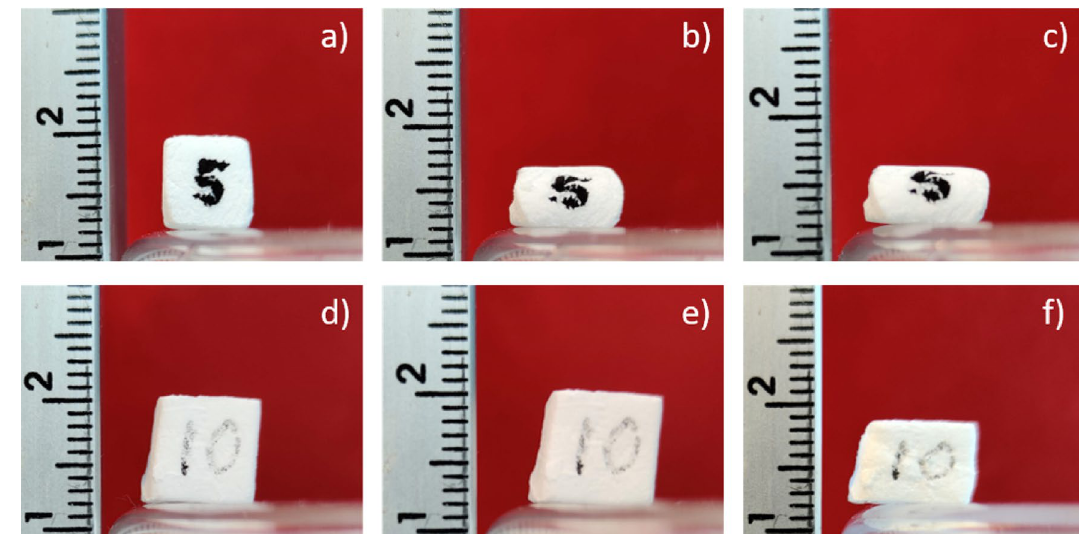
Figure 8. Cube-shaped foam samples made with either 5 or 10% polypropylene were exposed to increasing weights and photographs before and after the application. For the 5% sample the initial sample is depicted in ( a ). In ( b ), the sample was exposed once to a weight of 200g. In ( c ) the sample was exposed to the same 200 g one additional time. It can be seen that the sample strongly deforms after the first application with a small additional deformation after the second application. In the second row of the figure a 10% polypropylene sample ( d ) is depicted after being exposed to 200 g twice in ( e ) and after exposure to 1200 g in ( f ). It can be seen that the increase in polypropylene density results in a significantly increased